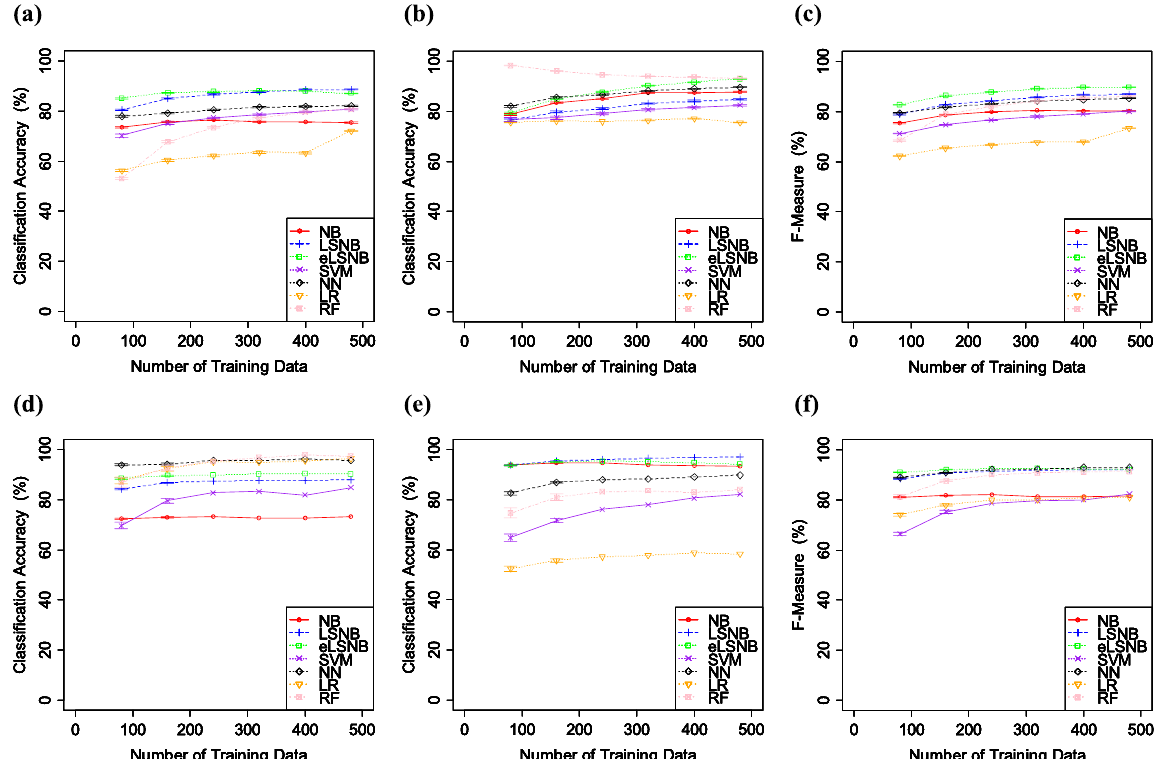
Figure 2. ( a ) spam classification accuracy, ( b ) ham classification accuracy and ( c ) F-measure values for SpamAssassin. ( d ) spam classification accuracy, ( e ) ham classification accuracy and ( f ) F-measure values for Ling-Spam. Error bars indicate the standard